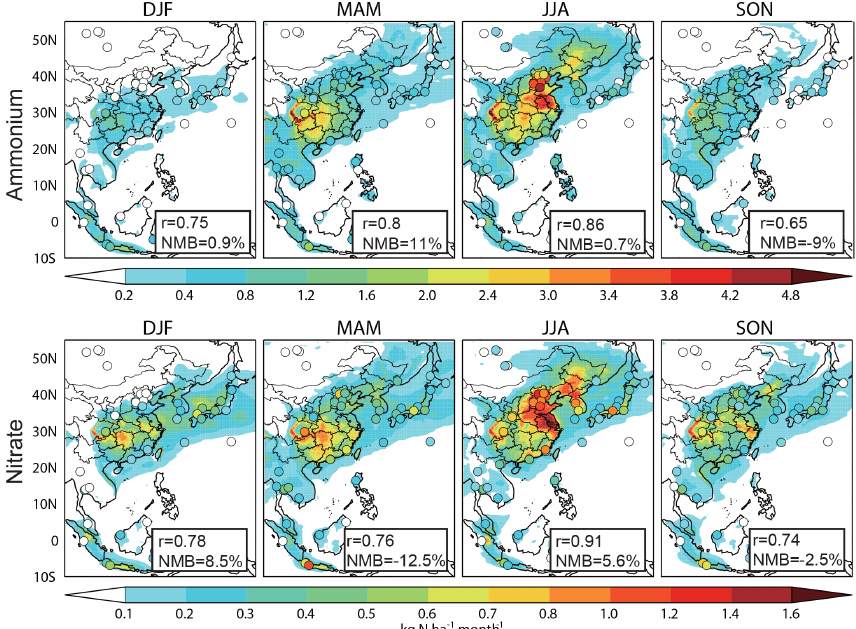
Figure 3. GEOS-Chem simulated seasonal mean ammonium (top panels) and nitrate (bottom panels) wet deposition fluxes for 2008–2010. The measurements from EANET (49 sites in the domain) and 10 CAS sites are over-plotted (circles). Correlation coefficients ( r ) and mean normalized biases (NMB) are given inset. The EANET data and model results are averaged for January 2008–December 2010, and the CAS data are for December 2007–November 2010. DJF represents December–January–February, MAM: March–April–May, JJA: